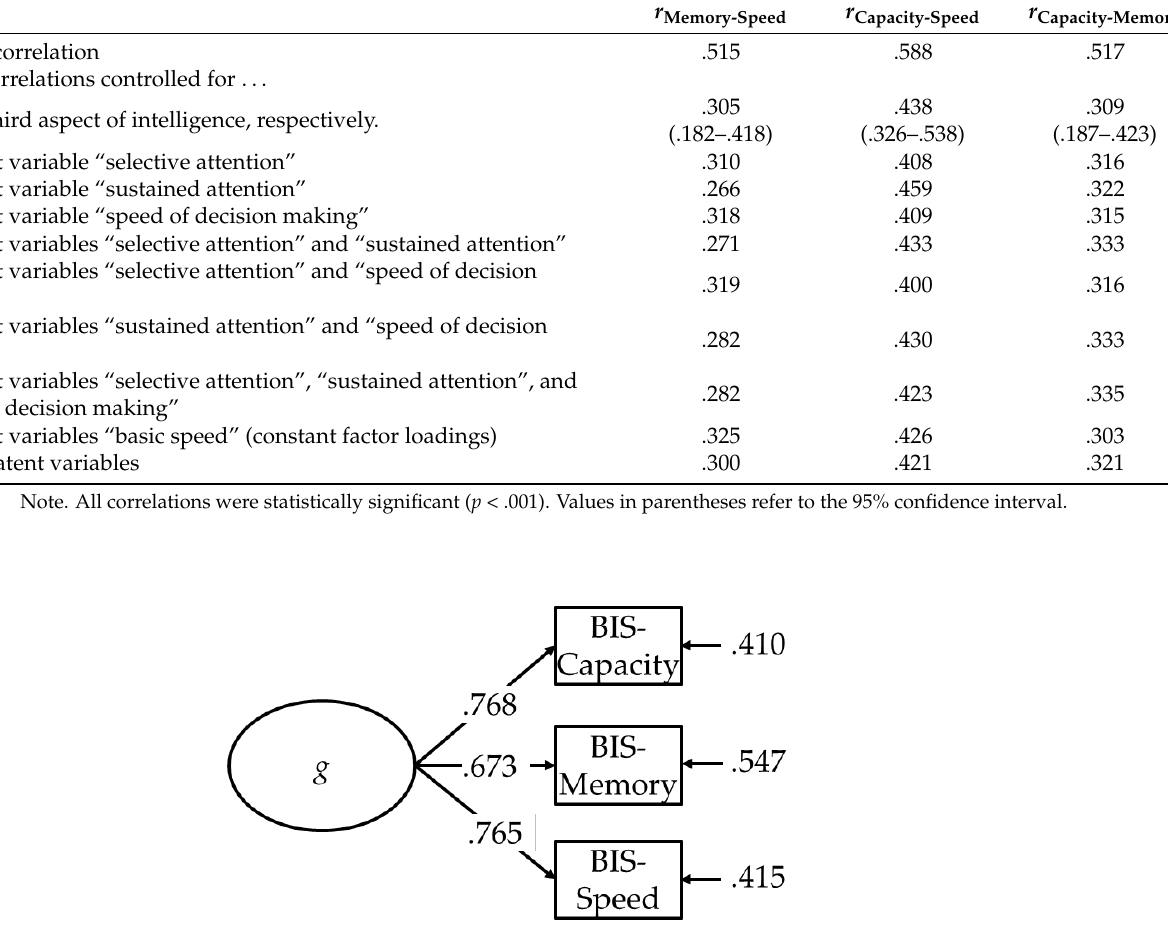
Table 1. Coefficients of Pearson and partial correlations between BIS-Capacity, BIS-Speed, and BIS-Memory.